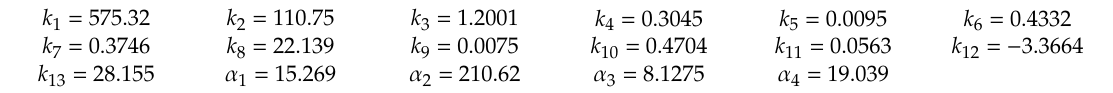
Table 1. Model parameter identification results.